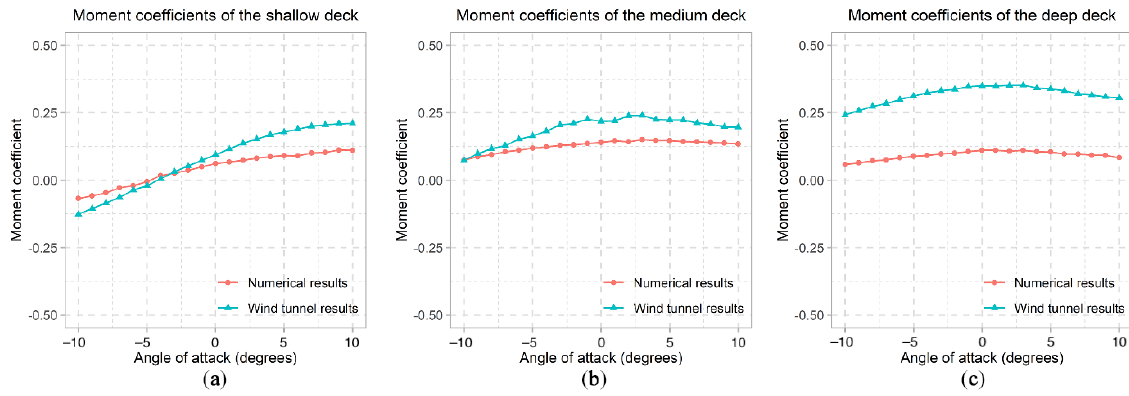
Figure 22. Moment coefficients of different bridge decks: ( a ) the shallow deck; ( b ) the medium deck; ( c ) the deep deck.